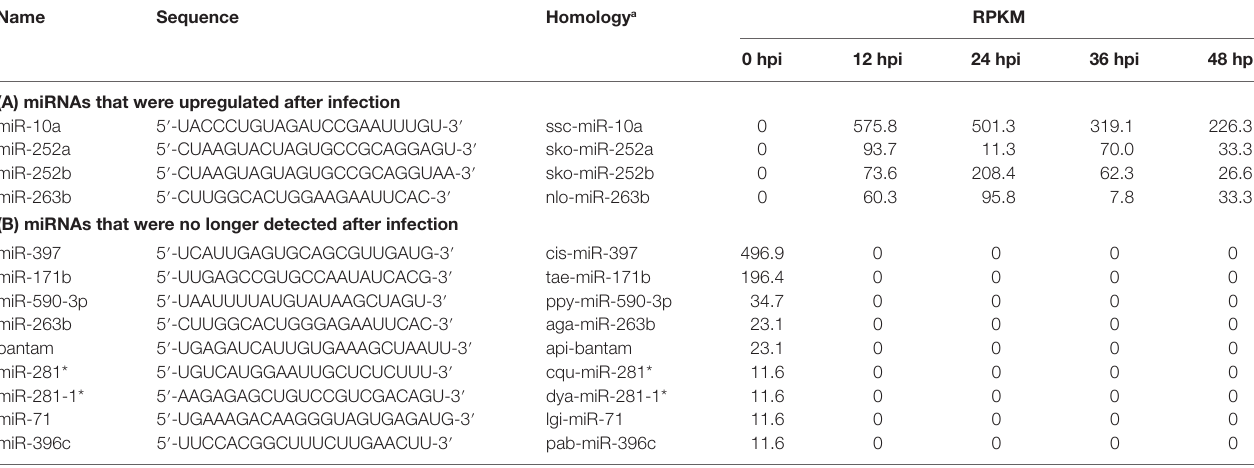
TaBle 2 | Differential expression of host microRNAs (miRNAs) in white spot syndrome virus-infected shrimp.